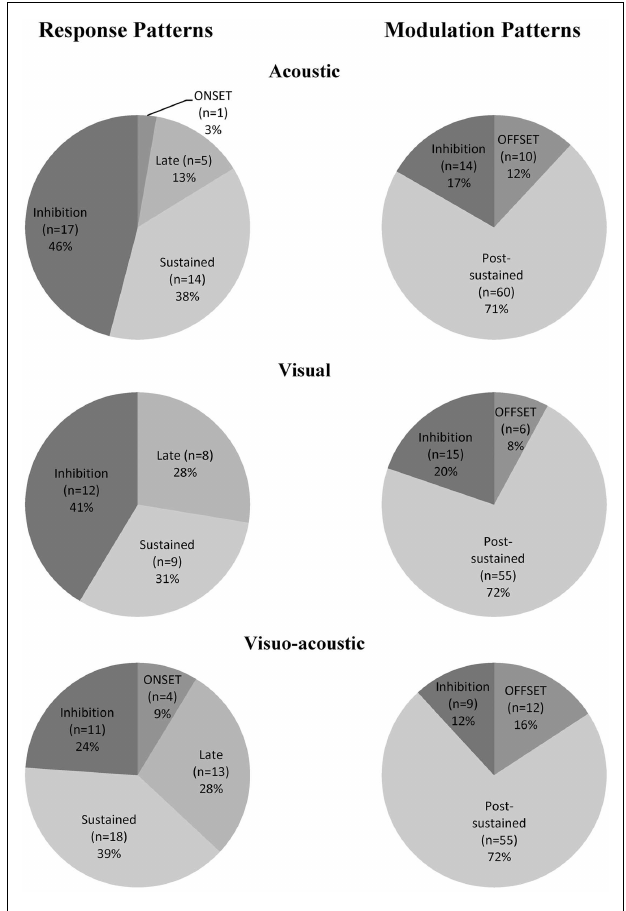
FIGURE 9 | Proportion of acoustic-, visual-, and visuo-acoustic- responding cells from PM according to the categorization presented in Figure 8 . Numbers represent percentages over the entire cell population from the two monkeys together. Movie S1 in Supplementary Material: illustration of the sensory-motor detection task execution.